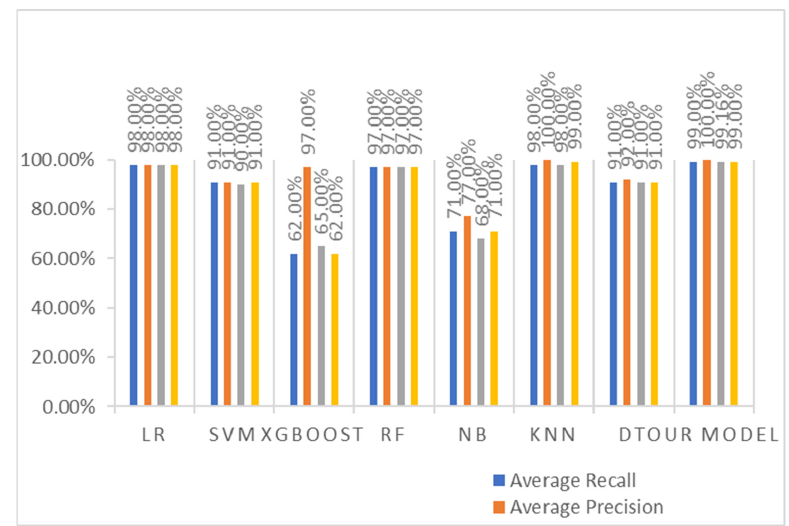
Figure 12. Comparison between different performance averages.